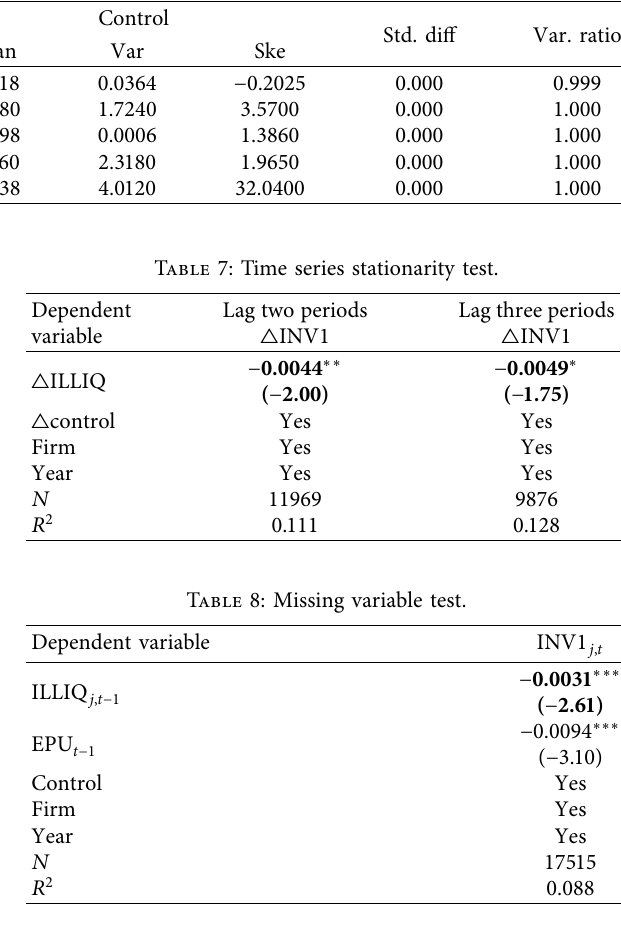
Table 5: Entropy balance matching result.